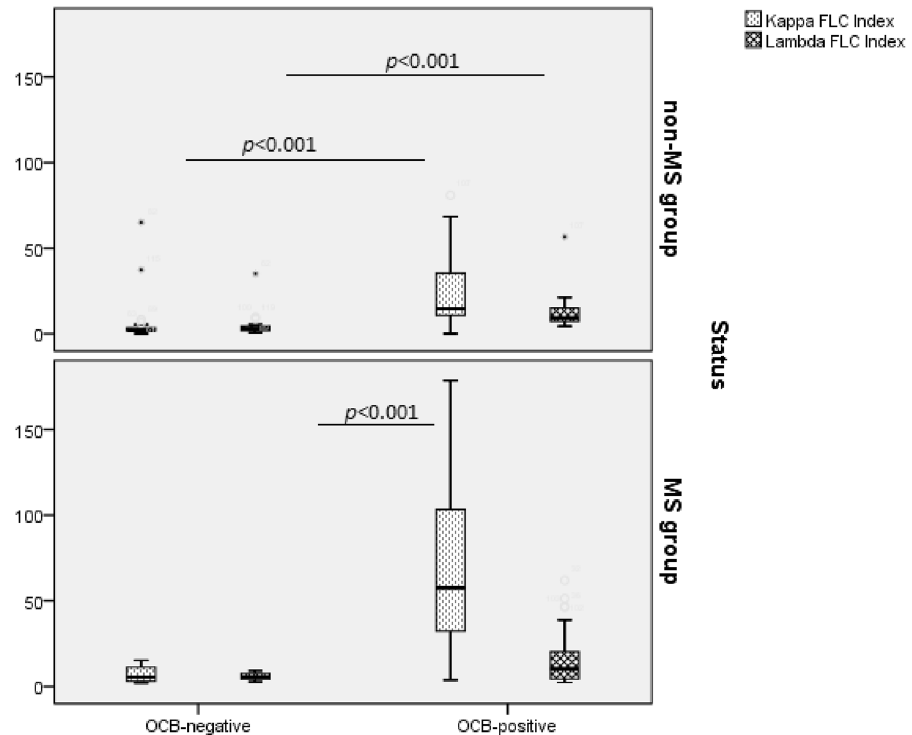
Figure 3. Comparative distribution of κFLC index and λ FLC index in multiple sclerosis (MS) and non-MS groups according to the oligoclonal bands (OCB) profile (U test of Mann–Whitney). Horizontal solid lines indicate